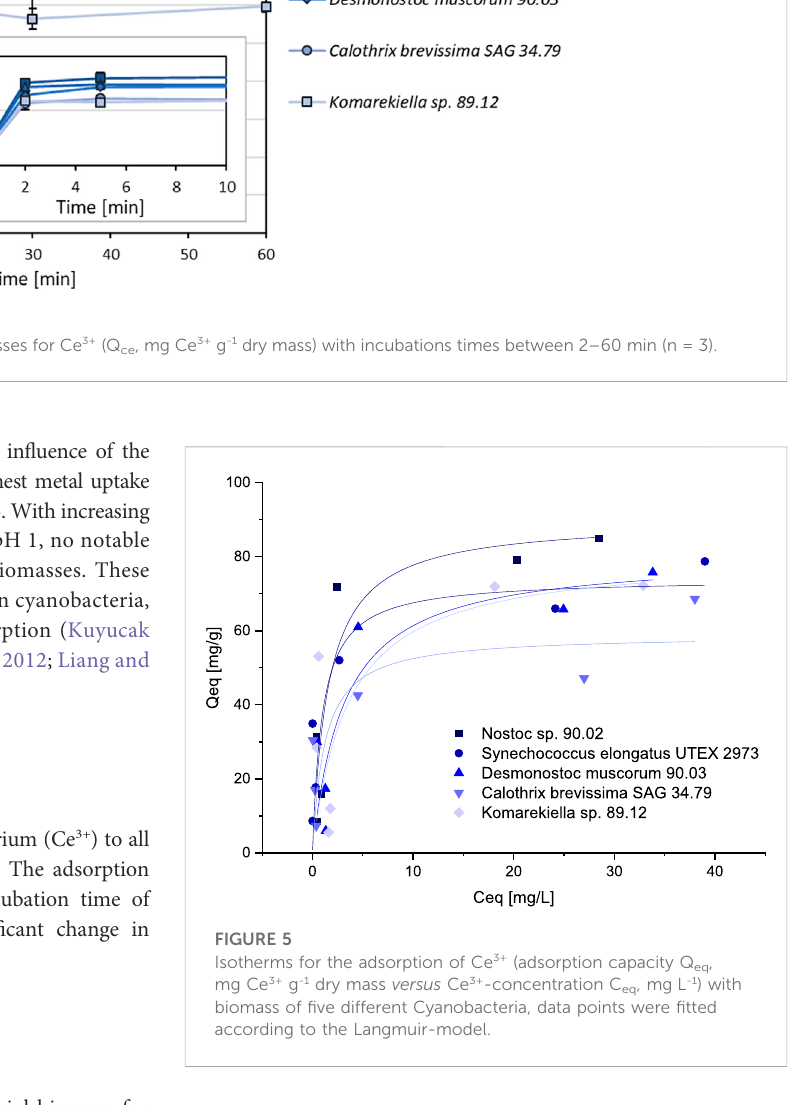
according to the